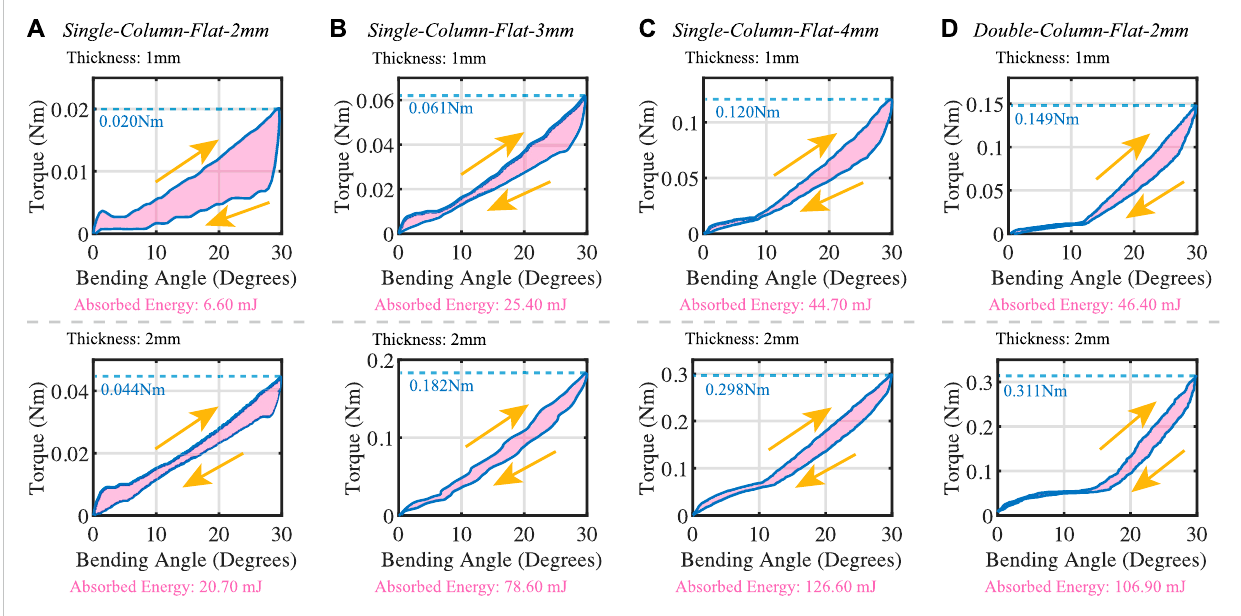
FIGURE 10 Bending stiffness test results of different kirigami-inspired springs (A) Single-Column-Flat-2mm pattern; (B) Single-Column-Flat-3mm pattern; (C) Single-Column-Flat-4mm pattern; (D) Double-Column-Flat-2mm pattern. Energy absorption of each kirigami-inspired springs during the bending cycles are indicated with the pink regions.